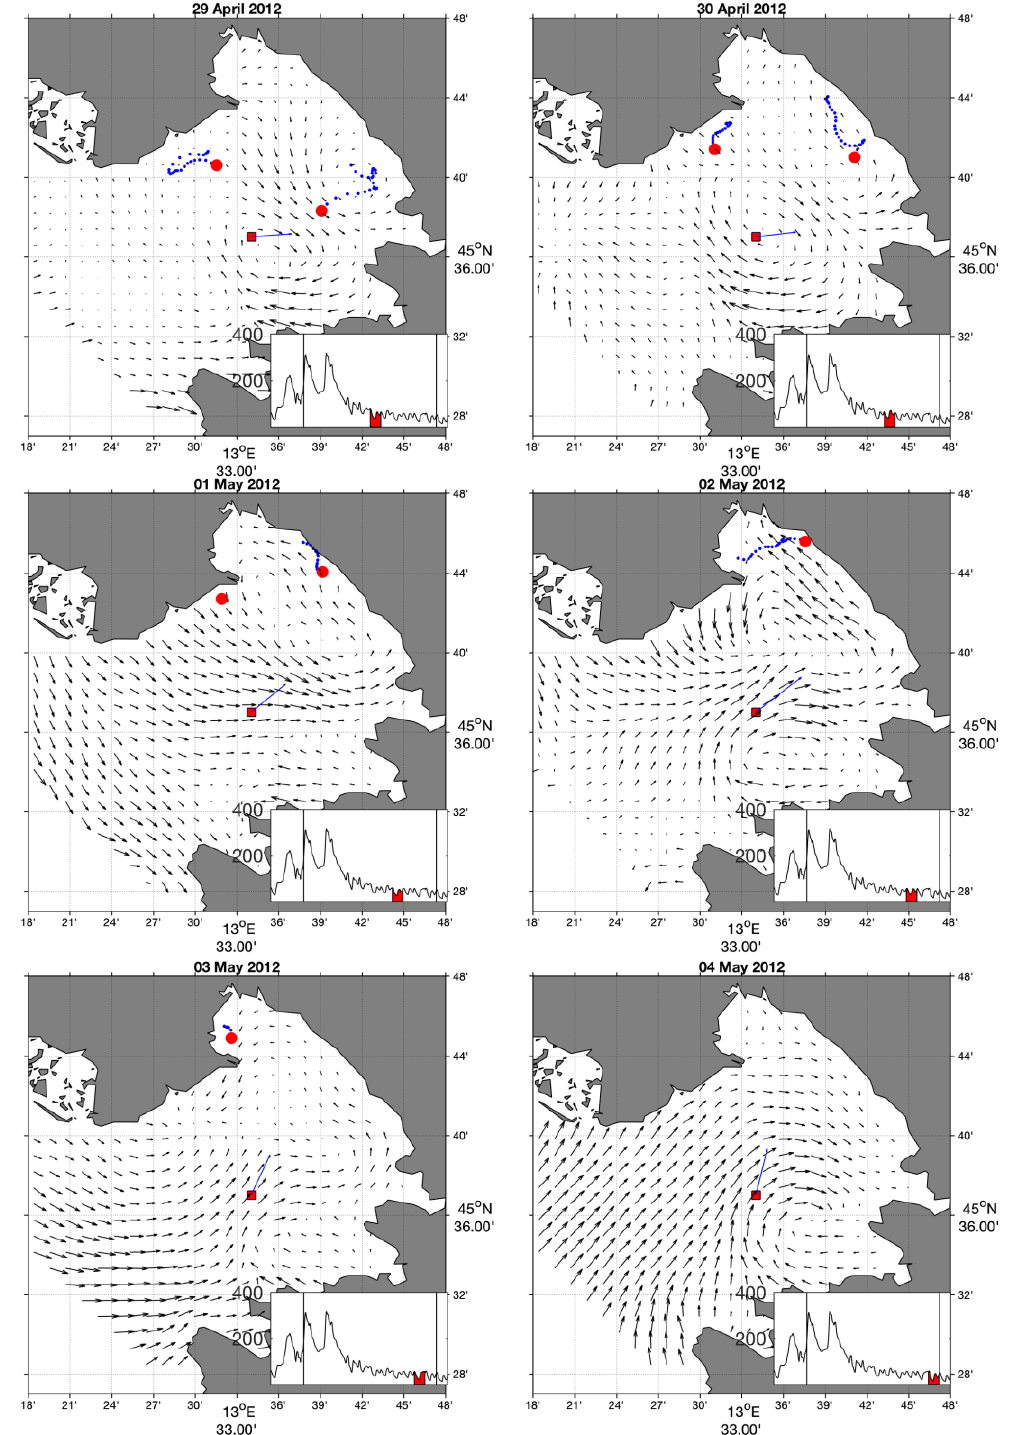
Figure 4. Same as Figure 3, for the time period of 29 April–4 May.